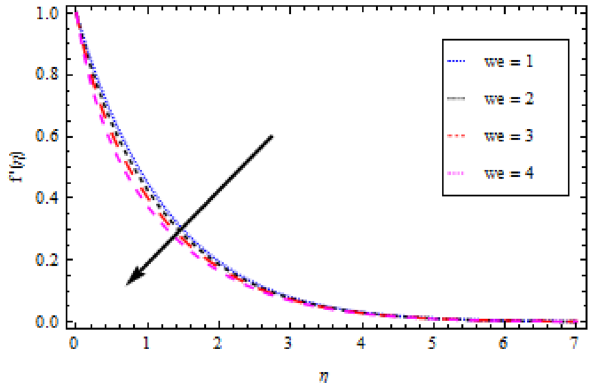
Figure 2. Velocity profile variation with respect to We .